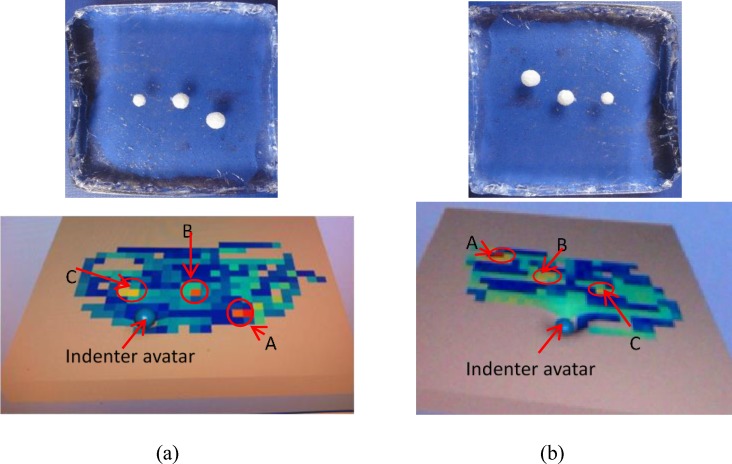
Two stiffness maps generated during 2 trials by visual stiffness feedback.The upper maps show the orientations of the artificial organ, whereas the lower maps show the corresponding stiffness.